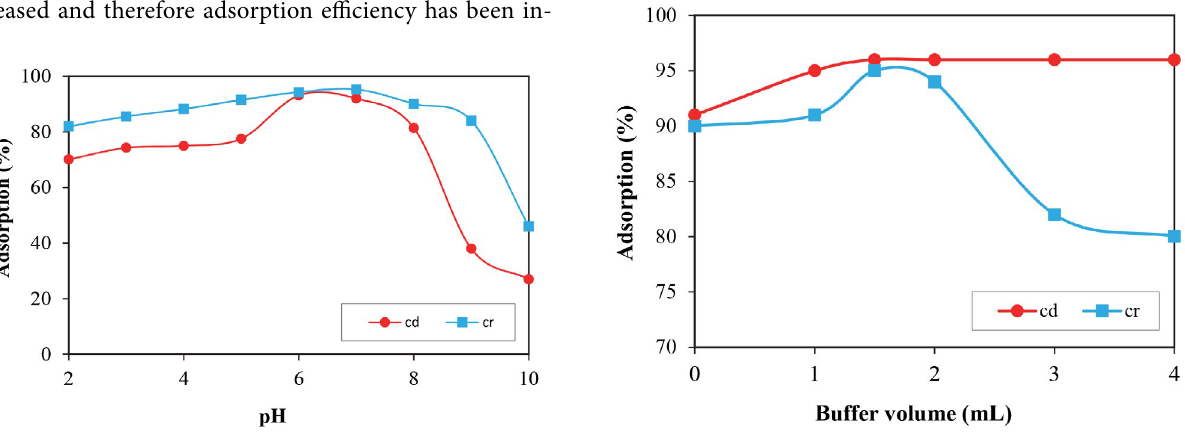
Fig. 4: Effect of buffer volume on removal of chromium (III) and cadmium (II) ions from aqueous solution using